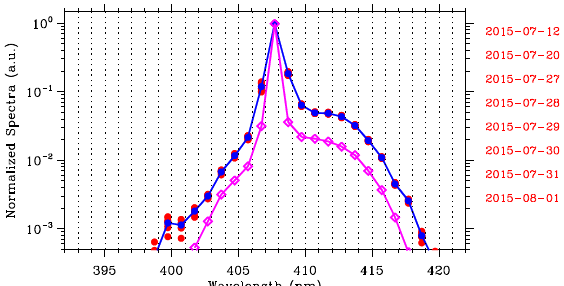
Fig. 3 Lidar-measured water vapor Raman spectra: red, nightly-mean spectra for 8 different clear-sky nights; blue, their average spectra; magenta, theoretical water vapor Raman spectra (according to [5]) smoothed with a 1.0-nm resolution. Note the lidar-measured water vapor Raman spectra are broadened by the lidar receiving optics, but nearly invariant and quite similar to the theoretical spectra in shape